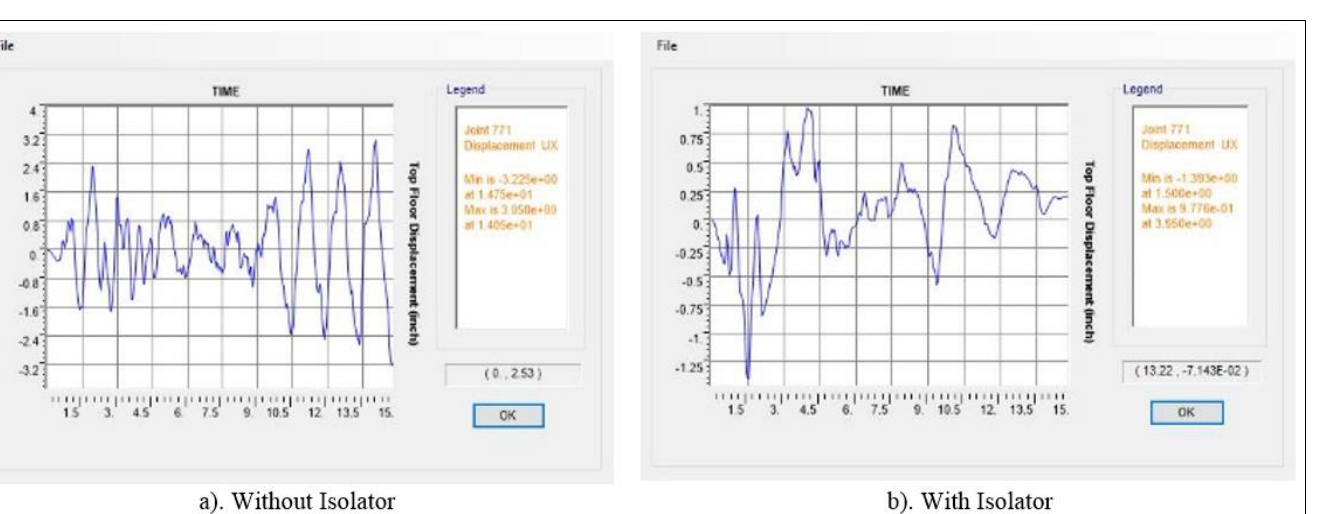
Figure 7: Top floor displacement vs time curve (15